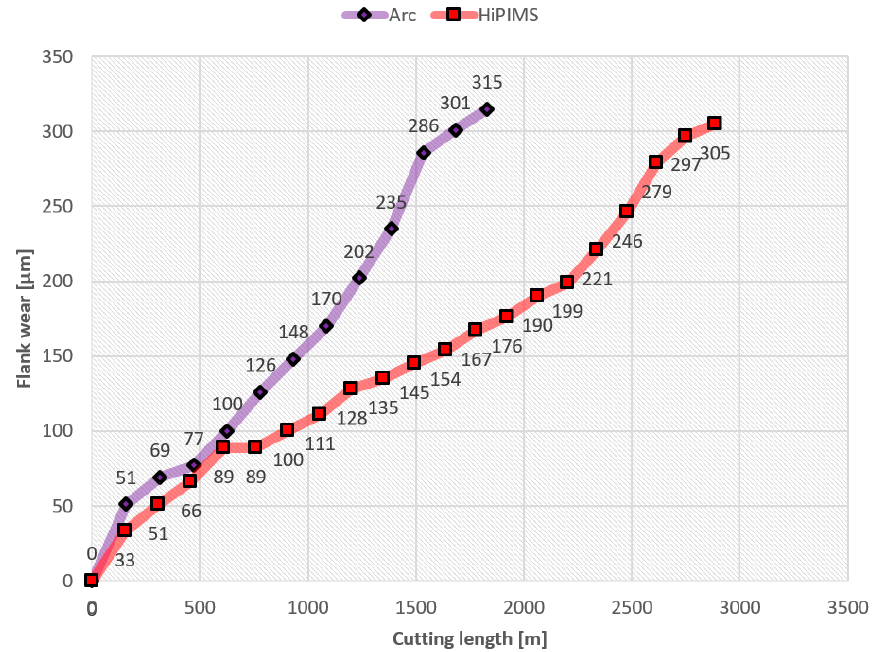
Figure 8. Flank wear vs. length of cut data for the coatings studied. Wear patterns were evaluated through 3D optical microscopy imaging (Figure 9).